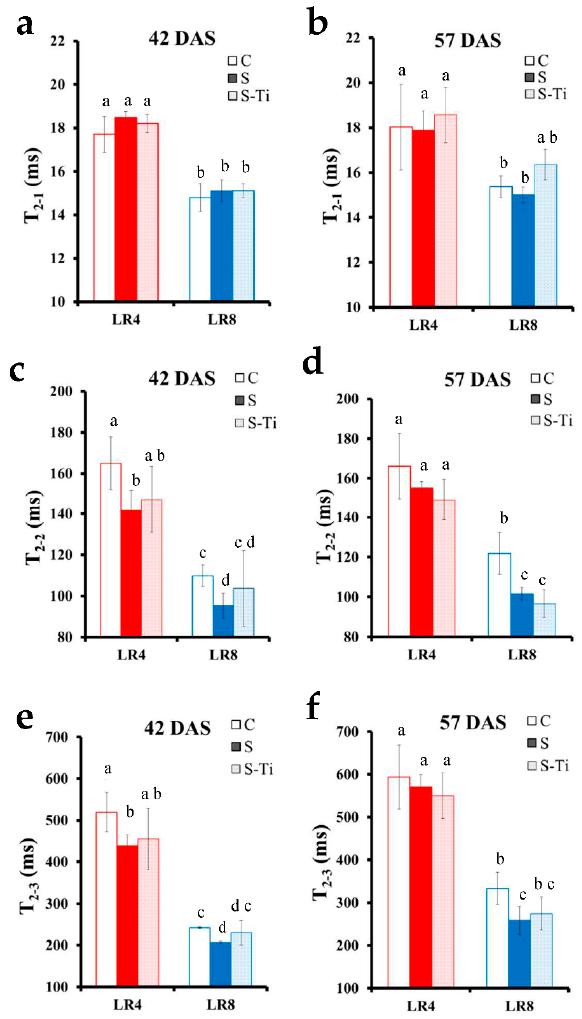
Figure 4. T 2 in ms of the first ( a , b ), second ( c , d ) and last peaks ( e , f ) obtained in leaves from two ranks and for all treatments at 42 days after sowing (DAS) ( a , c , e ) and 57 DAS ( b , d , f ). Bars represent standard deviation. Different letters means statistical differences ( p < 0.05).